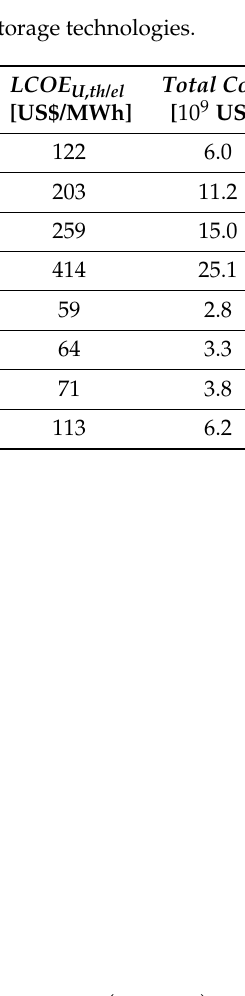
Figure 6. The levelized cost of energy as a function of the renewable share targets (𝑋 (cid:3019)(cid:3006)(cid:3020) fined in Equation (2) for the case in which the excess energy is not utilized or exported (to the grid). The LCOE U , th / el values are compared with a reference natural gas cost of USD 8/GJ in Australia (2021) [40] and the USD 2/kg target for hydrogen production [41].